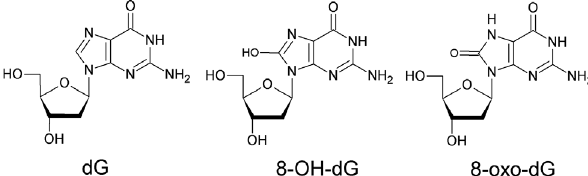
Figure 2 Structures of the mononucleoside 2′-deoxyguanosine (dG), the site-specific oxidative damage marker 8-hydroxy- 2′-deoxyguanosine (8-OH-dG), and its keto form 8-oxo-2′- deoxyguanosine